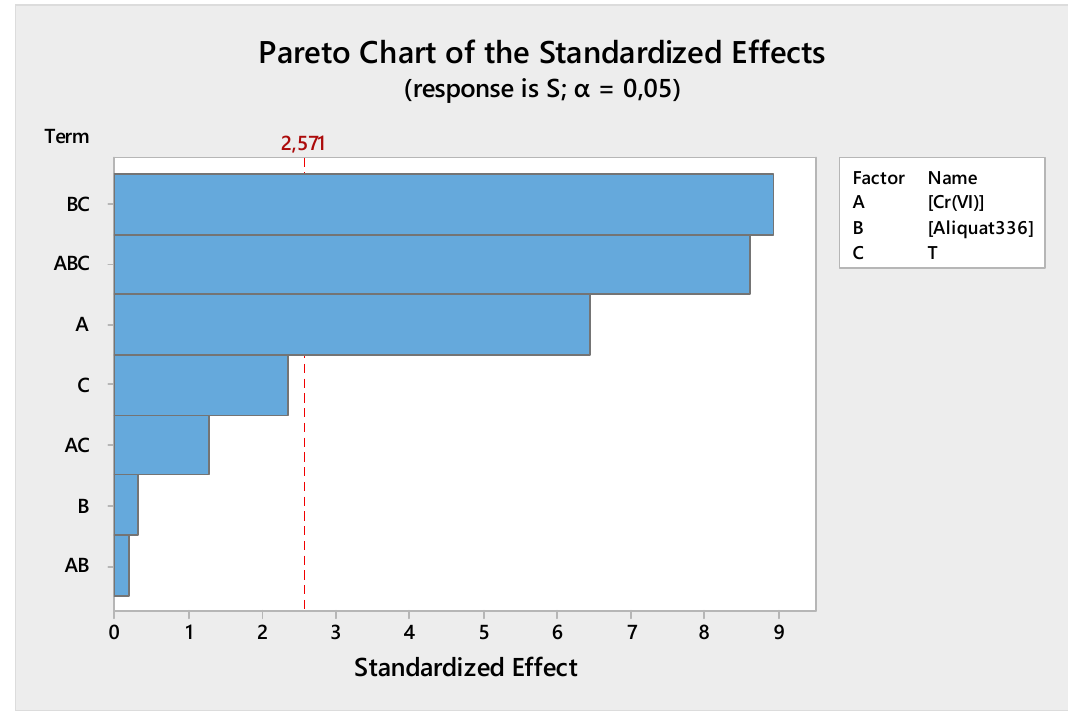
Figure 6. Feed phase Pareto chart of standardized effect.